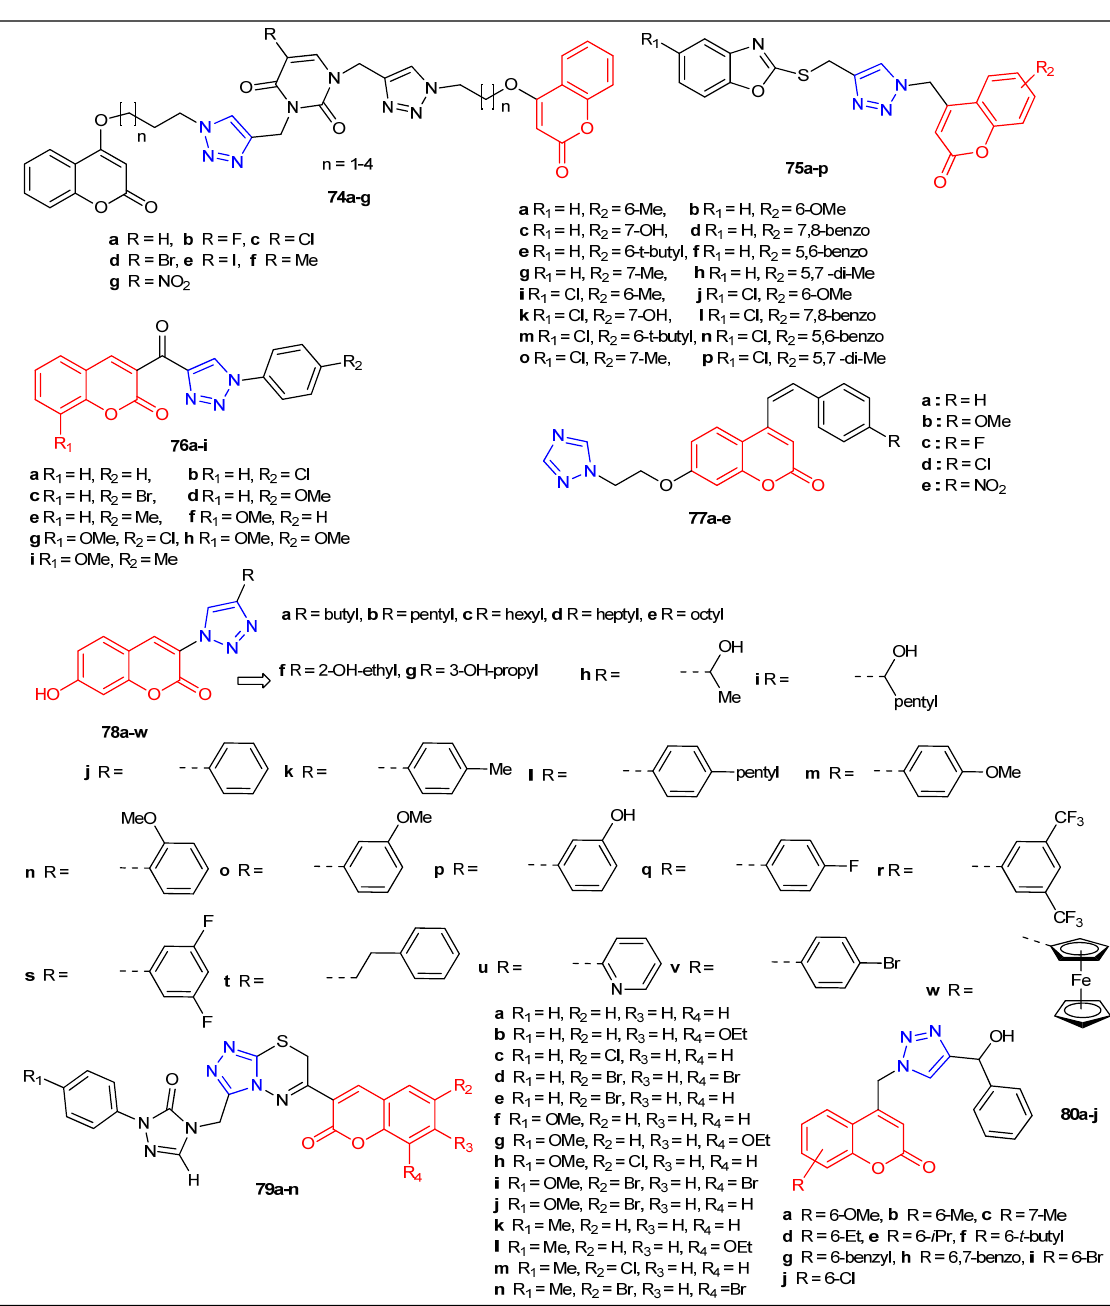
triazole derivatives ( 77a – e ) displayed around 44–51% inhibition against E. coli and S. aureus , whereas they did not show any activity toward S. typhi. It should be noted that antifungal data revealed that compounds 77c and 77d established the broadest spectrum of inhibitory activity (74.07% and 66.66%) toward A. flavus . The remaining coumarin triazole deriva- tives 77c , 77d , and 77e are inactive against C. albicans ; 77a and 77b were inactive against A. flavus [63].